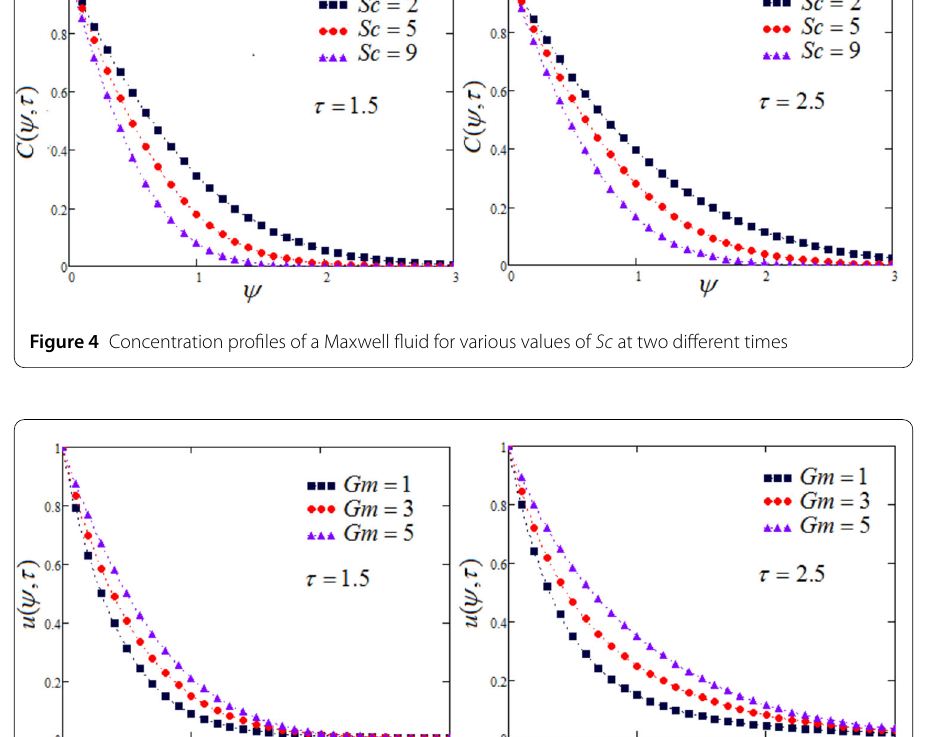
Figure 5 Velocity profiles of a Maxwell fluid for various values of Gm at two different